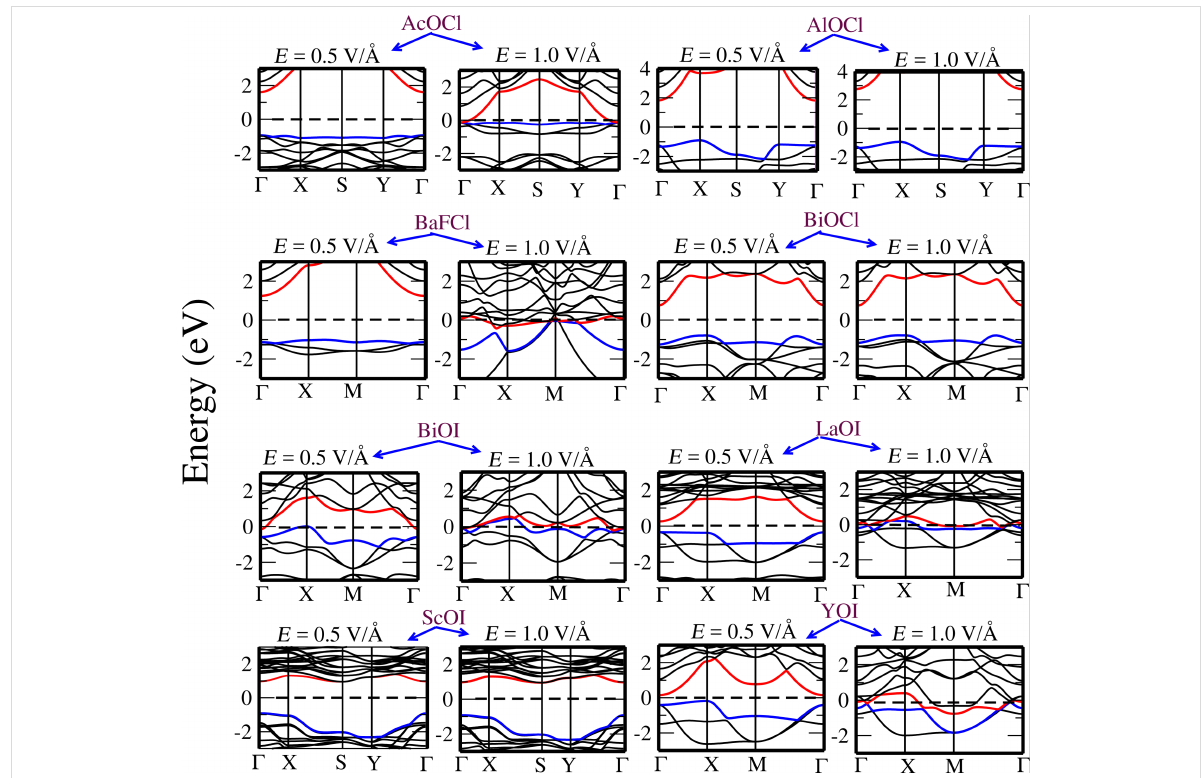
Figure 12: Evolution of the electronic band structure of: AcOCl, AlOCl, BaFCl, BiOCl, BiOI, LaOI, ScOI, and YOI single layer as a function of applied electric field. Calculations are performed with PBE. The top of the valence band (blue) and bottom of conduction band (red) are indicated. The Fermi level is set to 0